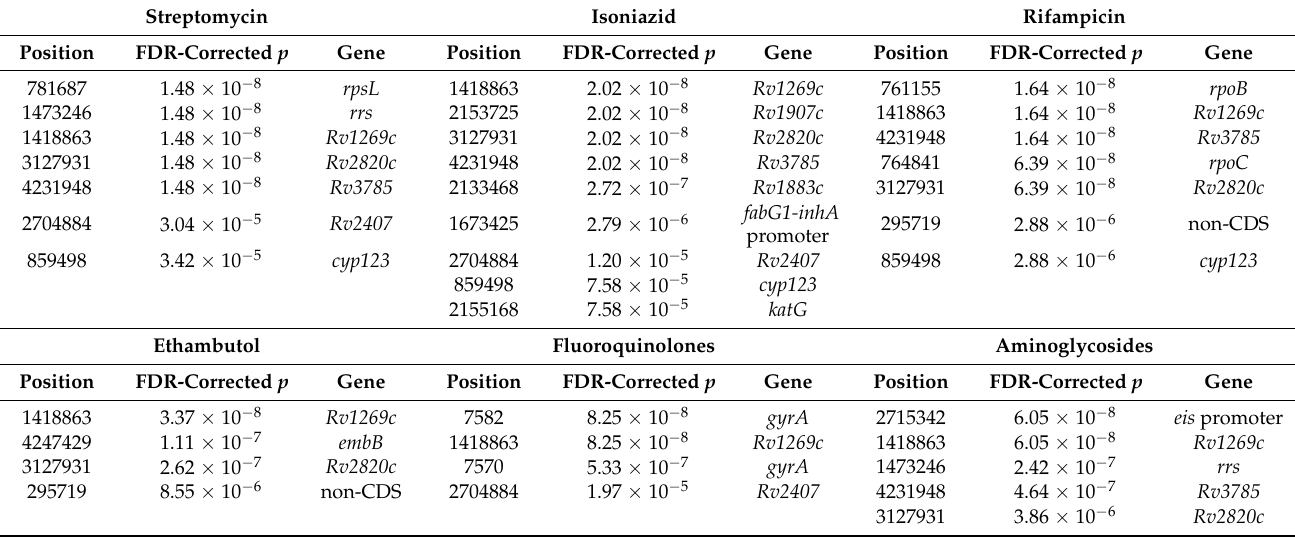
Table 2. Statistically significant PhyC-based GWAS